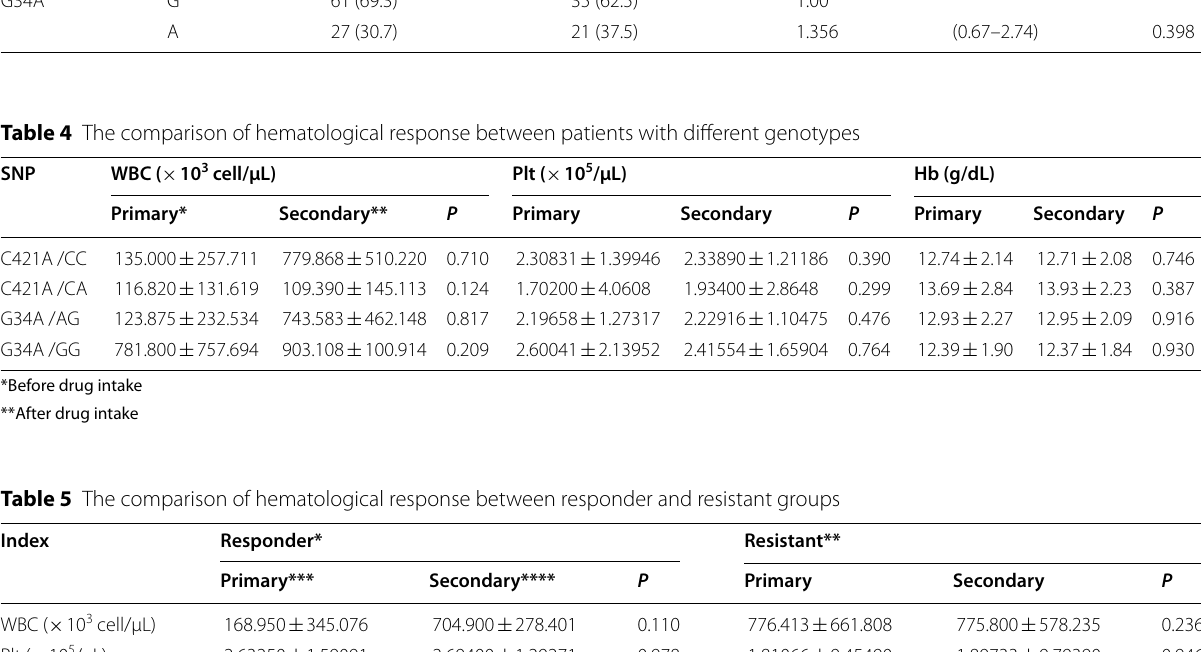
*WBC < 10 10 9 /L/ platelet < 450 109/L/ an absence of myelocytes, promyelocytes, or myeloblasts in peripheral blood × × **WBC and platelet counts have not returned to normal, there are immature cells seen in blood ***Before drug intake